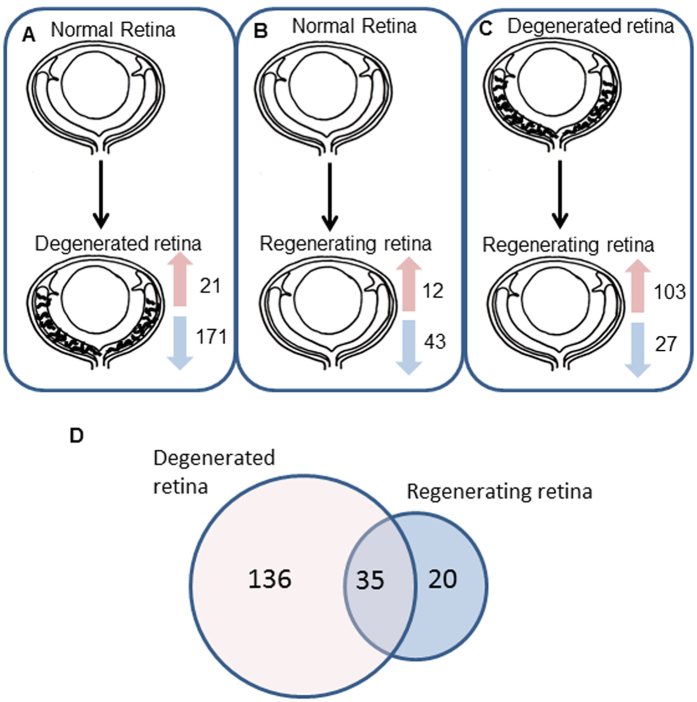
Differential expression of proteins between normal, degenerated and regenerating zebrafish retina.Numbers of proteins differentially expressed between (A) normal and degenerated retina, (B) normal and regenerating retina and (C) degenerated and regenerating retina. Red arrows indicate the number of upregulated proteins and blue arrows indicate the number of downregulated proteins that were differentially expressed. (D) Venn diagram shows the number of proteins differentially expressed in the degenerated retina and regenerating retina as compared to normal retina. Numbers in both circles are common to both degenerated and regenerating retina.